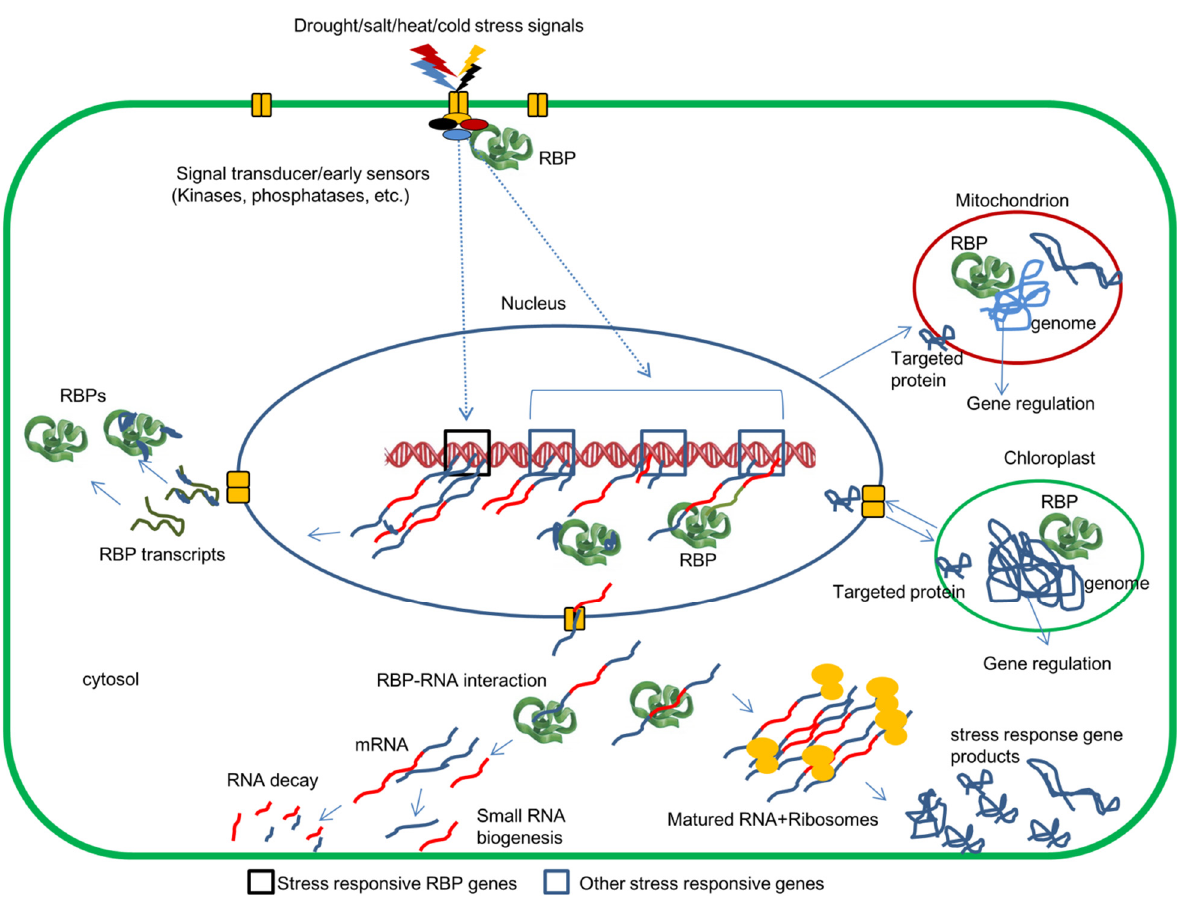
Figure 1. A simplified diagrammatic representation of activation of RBP and other genes by abiotic stress signals (drought, salt, heat, and cold) and RBP interactions with RNAs of nuclear, chloroplast, and the mitochondrion at various levels to regulate stress responses in a plant cell. The stress signals perceived by the sensors were transduced to the nucleus, where activation of several genes, including RBP genes, was happening to adjust the cellular conditions to stress. The RBPs interact with various stress response transcripts and modulate their expression by altering their stability, splicing, cellular localization, availability/degradation, and translational repressions.